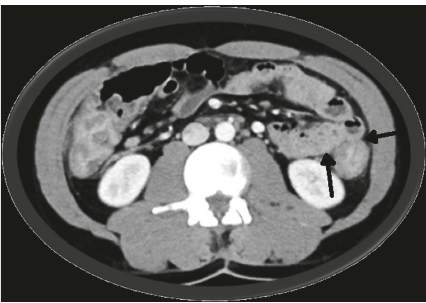
Figure 1: Transverse abdomen CT. Diffuse abnormal colonic thick- eningconsistentwithpancolitis(arrows).Thesmallbowelisnormal.